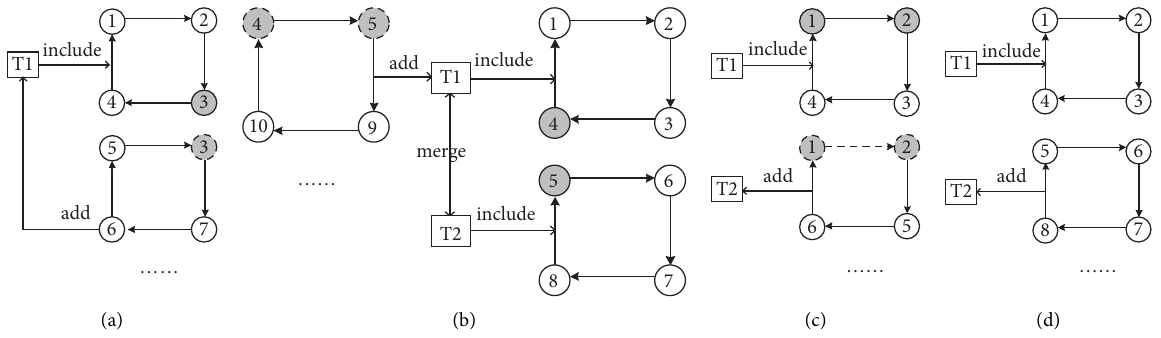
Figure 1: Several situations of whether there are common nodes between new cycles and sets: (a) the case that a new cycle has a common node and no common edge with an existing set; (b) the case that a new cycle has a common node and no common edge with existing sets; (c) the case that a new cycle has a common node and a common edge with an existing set; (d) the case that there is no common node between a new cycle and all existing